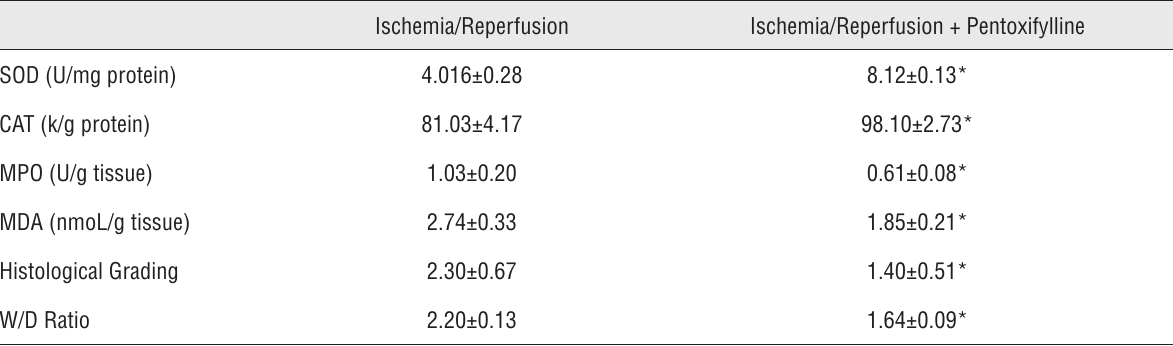
Table 1 - The tissue CAT and MPO activities and levels of SOD and MDA in testicular tissues and score of testicular histological changes and muscle wet/dried weight (W/D)